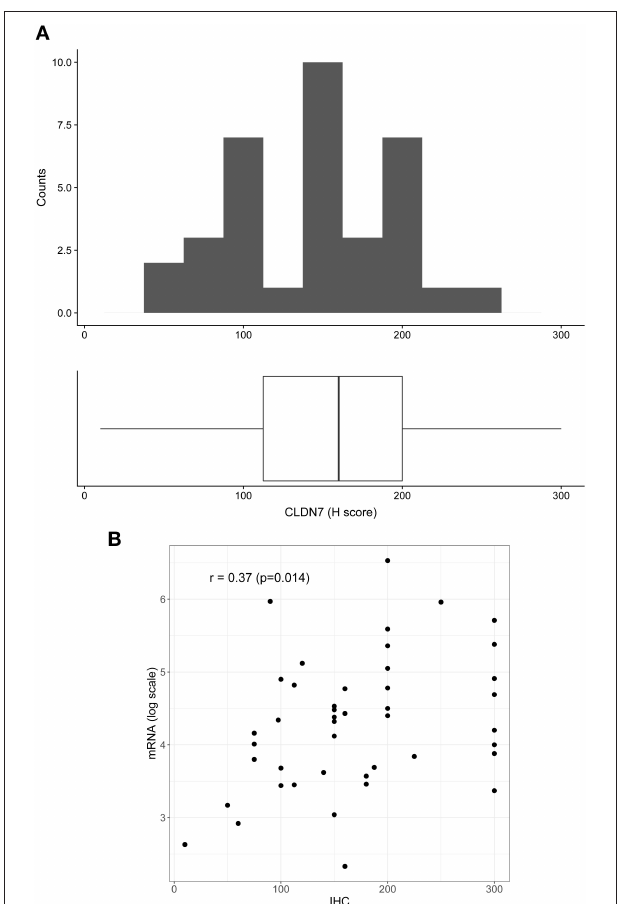
FIGURE 2 | Distribution of H score in the patient positive for claudin-7 immunostaining ( n = 45). (A) The distribution is fairly symmetric with a range going from 10 to 300. Figure shows histogram (upper side) and boxplot (lower side) of claudin-7H score. (B) Scatter plot of claudin-7 mRNA expression values (log scale) and H-score, reflecting increase in H-score associated to a higher mRNA expression ( r = 0.37, p = 0.014).